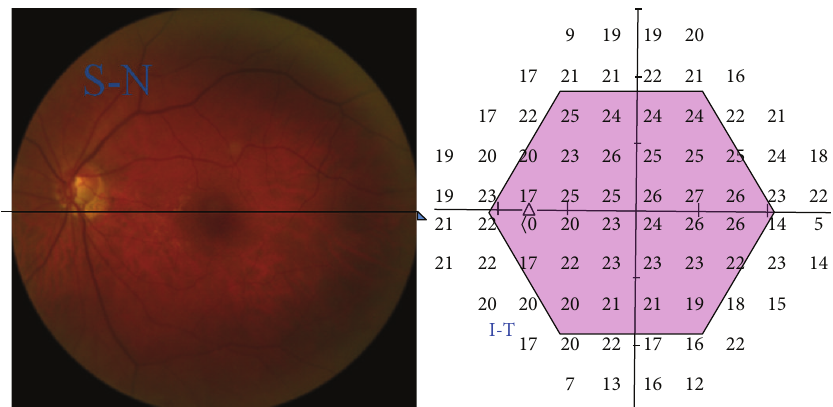
Figure 3: Quadrant correspondence between Mp-1 and Humphrey.